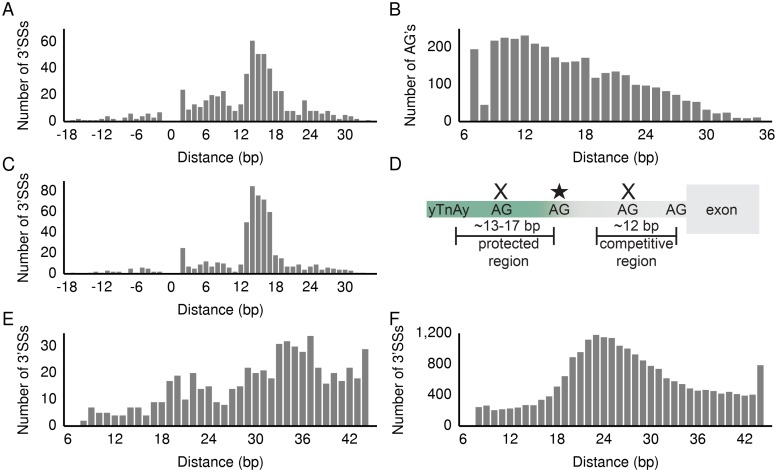
Location of predicted branch point relative to cryptic and canonical 3’SSs and model of cryptic 3’SS selection.(A) Distance from highest scoring BP predicted for associated canonical 3’SSs to the corresponding proximal cryptic 3’SSs. A negative distance indicates that the cryptic 3’SS is upstream of the BP predicted for the canonical 3’SS. The small spike at 2 bp indicates that in a few cases the adenine in the cryptic 3’SS is predicted to be the BP adenine for the canonical 3’SS. (B) Distance from highest scoring BP predicted for control 3’SSs to downstream intronic AG dinucleotides that are not annotated as 3’SSs. (C) Distance from either highest or second highest scoring BP predicted for canonical 3’SSs to their associated cryptic 3’SSs (see Methods). (D) Model for proximal cryptic 3’SS selection in SF3B1 mutants. yTnAy is the human BP motif. AG dinucleotides located at the edge of the sterically protected region can be used as 3’SSs in SF3B1 mutants (star). AG dinucleotides located in the protected or competitive regions (X’s) are respectively sterically hindered from being selected as 3’SSs or out-competed by the canonical 3’SS. Distance from predicted BP to 3’SS for (E) associated canonical 3’SSs and (F) control 3’SSs (see Methods) is significantly different (p < 10-23, Mann Whitney U).